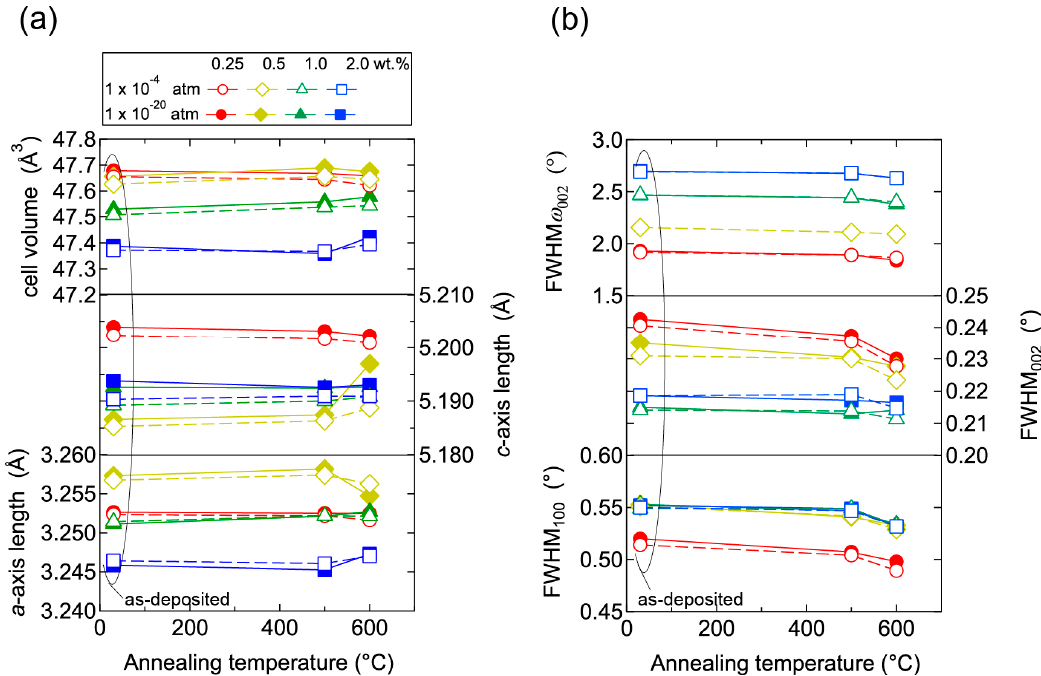
Figure 12. Plots of ( a ) a - and c -axis lengths and cell volumes as a function of annealing temperature, and ( b ) FWHM of rocking curves for 002 diffraction peaks (FWHM ω 002 ) and FWHM of 002 and 100 diffraction peaks (FWHM 002 , FWHM 100 ) as a function of annealing temperature for films post-annealed at a P O2 of 1 × 10 − 20 ( solid lines ) and of 1 × 10 − 4 ( dotted lines ) atm.